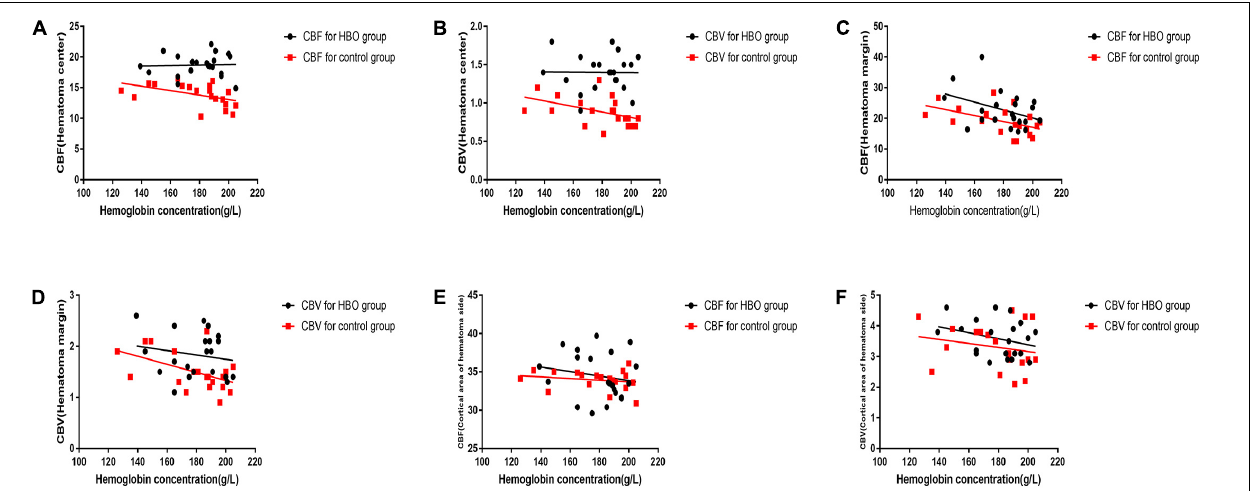
Frontiers in Human Neuroscience |